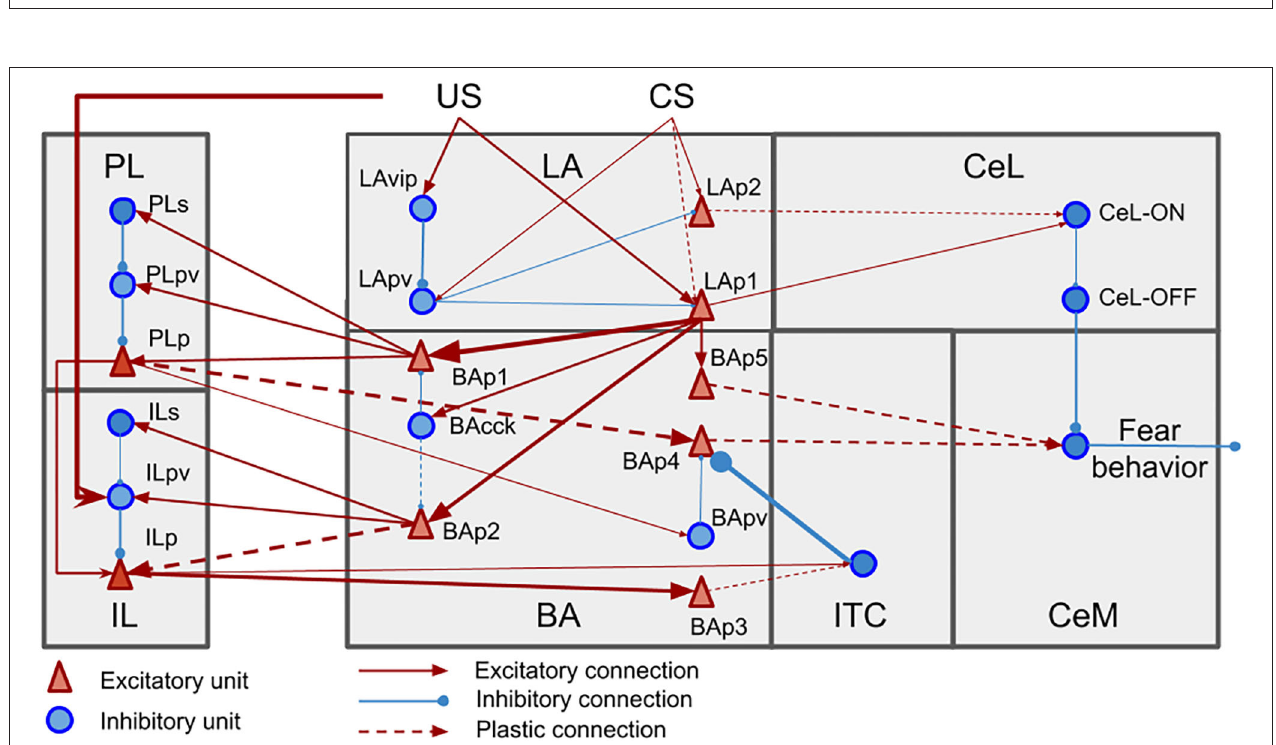
FIGURE 2 | Neural units and connection pathways of the model. The width of the connections is roughly proportional to the connection weights at the beginning of the simulations.